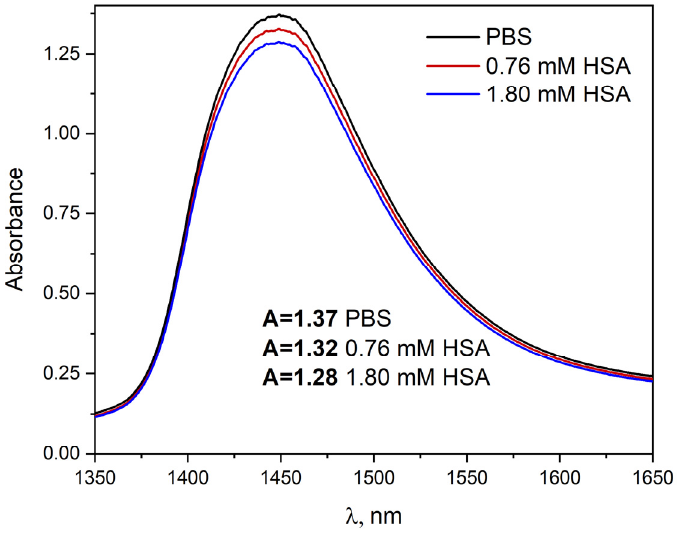
Figure 9. Absorption spectra of buffer solution of HSA (0.76 and 1.80 mM). Measurements were made using a 0.2 cm quartz cuvette. The PBS plot represents the spectra in a wide range of HSA concentration (15 to 600 µM).